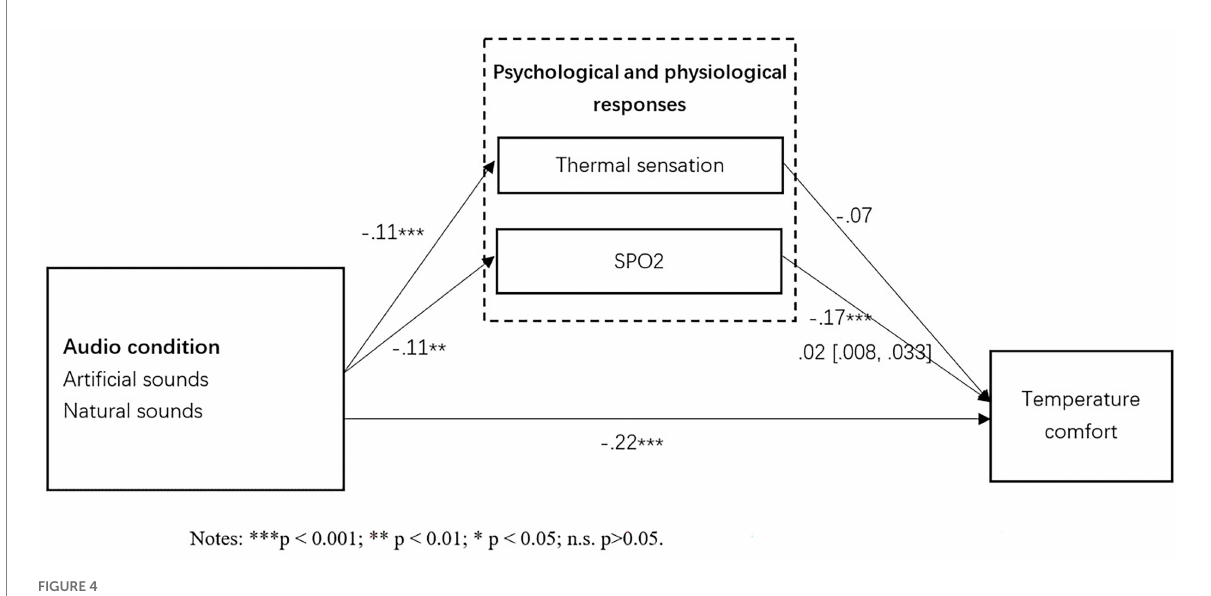
FIGURE 4 Mediating effects.